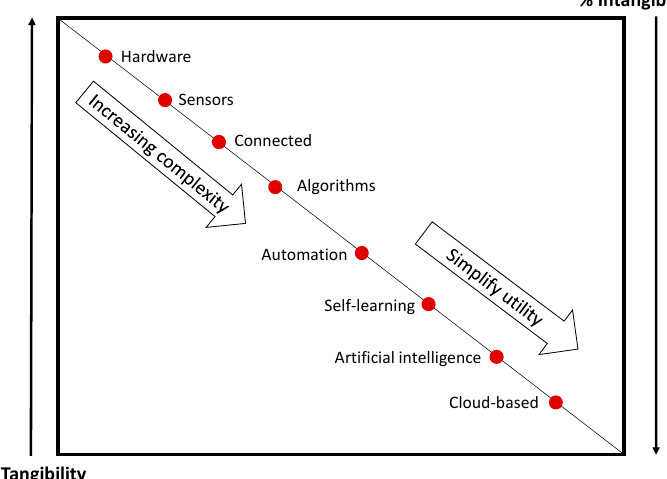
Figure 6. Options for increasing the enablers of an offering, by increasing the complexity of a simple offering and simplifying the utility of a complex offering, on a tangibility scale.